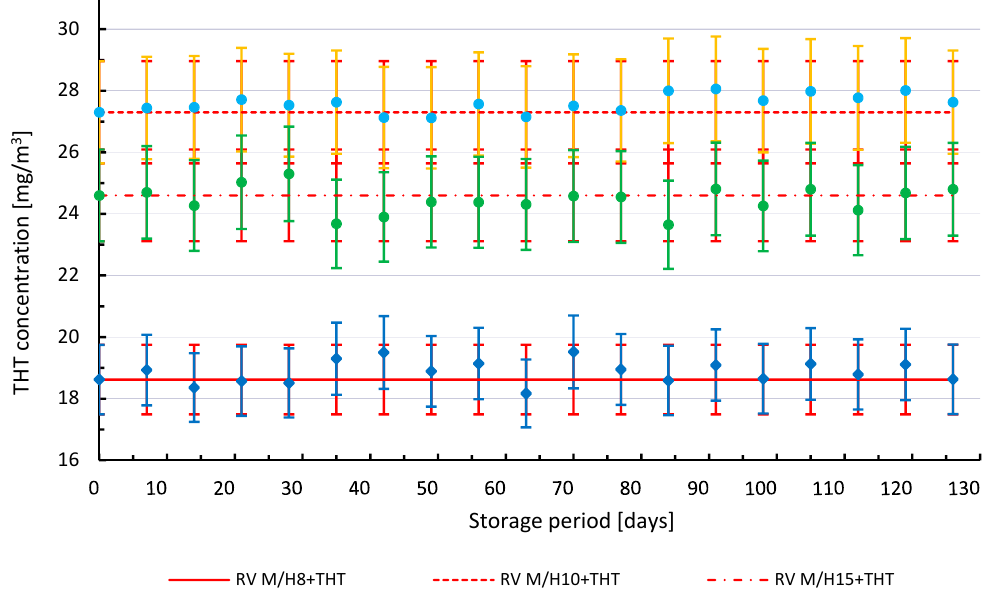
Figure 5. Results of testing the stability of THT concentration in gaseous mixtures of M/H + THT (T = 20 °C and P = 101.325 kPa).